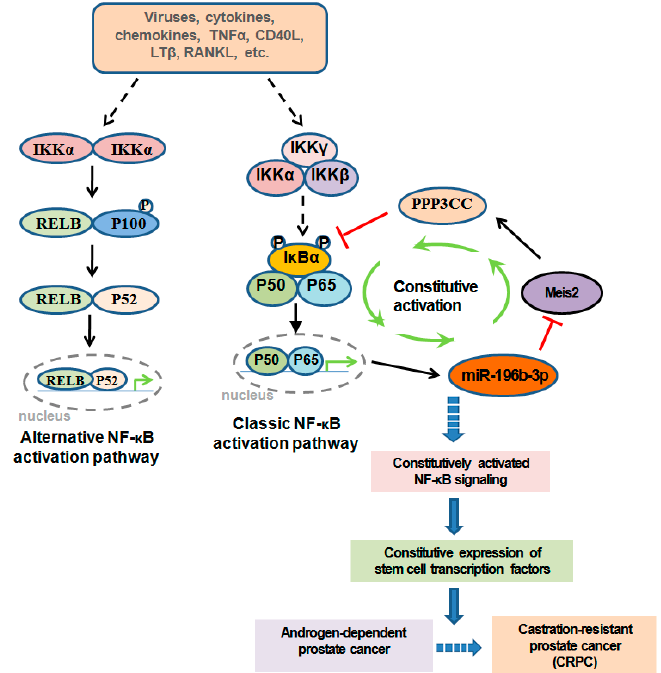
Figure 1. Diagram of traditional NF- κ B pathway and the constitutively activated feed-forward signaling circuit in CRPC. A constitutively activated feed-forward circuit, composed of IkB α /NF- κ B(p65), miR-196b-3p, Meis2, and PPP3CC, formed during and required for CRPC development. Constitutive activation of this circuit is independent of traditional IKK β /NF- κ B pathways, suggesting that targeting this circuitcould be important for CRPC treatment.